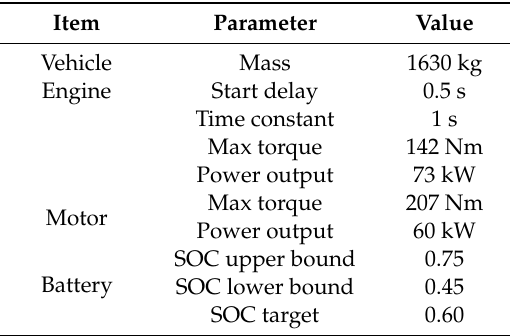
Table 2. Key simulation parameters.